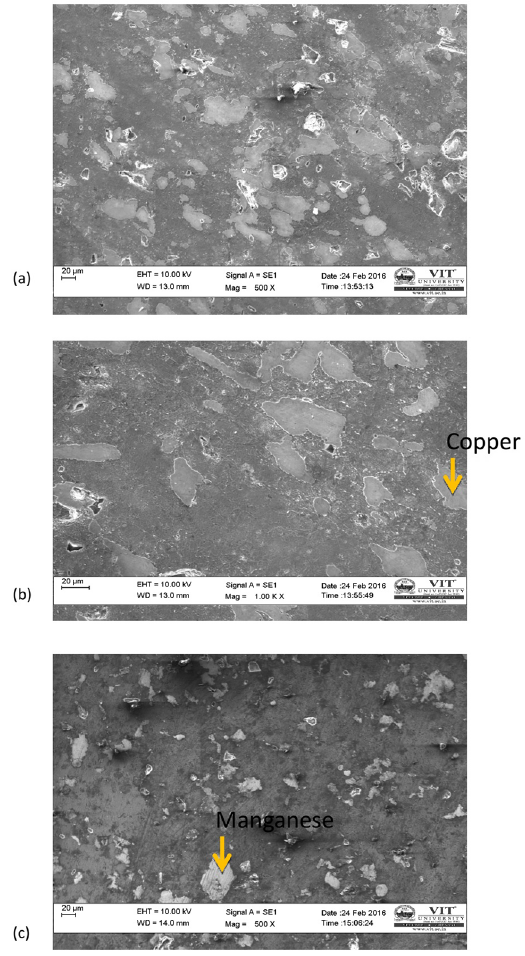
Figure 4. SEM micrographs of etched Aluminium compacts sintered in) Al-20%Cu-15%Mn (a) Conventional Sintering; (b) Microwave Sintering; (c) Spark Plasma Sintering